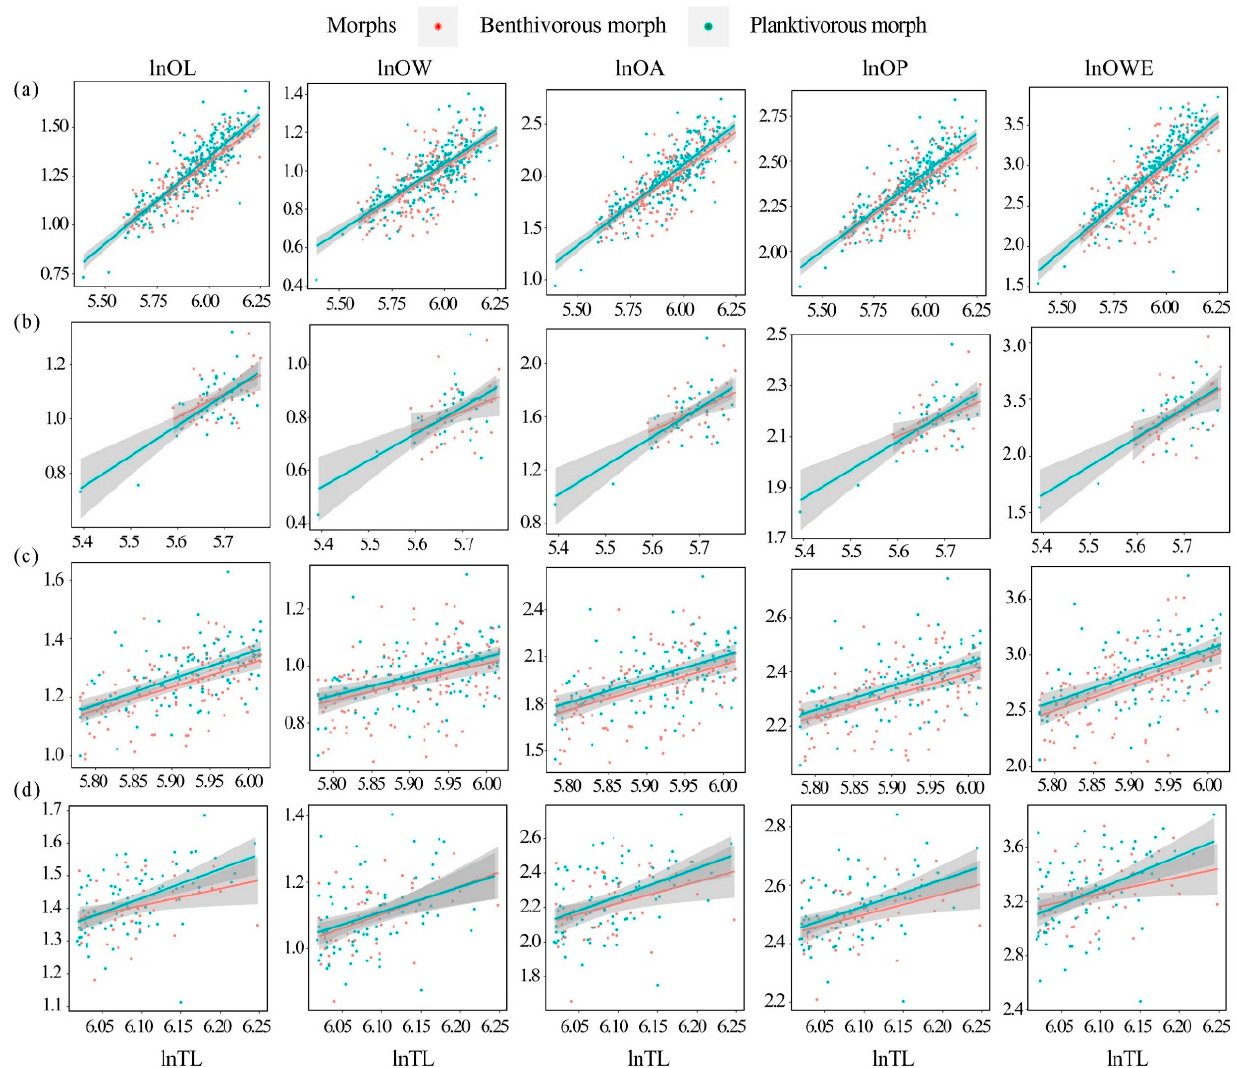
Figure 4. Relationships of total fish length with the otolith shape indices according to Schizopygopsis thermalis captured from Lake Amdo Tsonak Co. Redpoint and linear equation belong to benthivorous morph while green point and linear equation pertain to planktivorous morph. ( a – d ) represent the combination of all TL groups, first TL group, second TL group, and third TL group, correspondingly. The average otolith shapes of the two morphs in all TL groups were reconstructed based on wavelet transformation (Figure 5). For all TL groups combined, morphological dif- Table 2. The relationship between total fish length (TL) and shape indices (OL, OW, OA, OP, and ferences in otoliths of the two morphs were mainly observed in specific regions, especially OWE) (after log transformed) of otolith in the combination of all TL groups, first TL group, second in the rostrum, excisura ostii, posterior side, and region between the posterior and ventral TL group, and third TL group, respectively. Note: a: intercept; b: slope; R 2 : coefficient of otolith (CAP, F = 3.4187, p < 0.05; Figure 5a). This was consistent with the variability in the means and standard deviations of wavelet coefficients. The intraclass correlation coefficient explained a large proportion of the intraspecific variation (Figure 5a) and revealed a high level of intermorph variation in the wavelet coefficients for the mean outline at 30–90 ◦